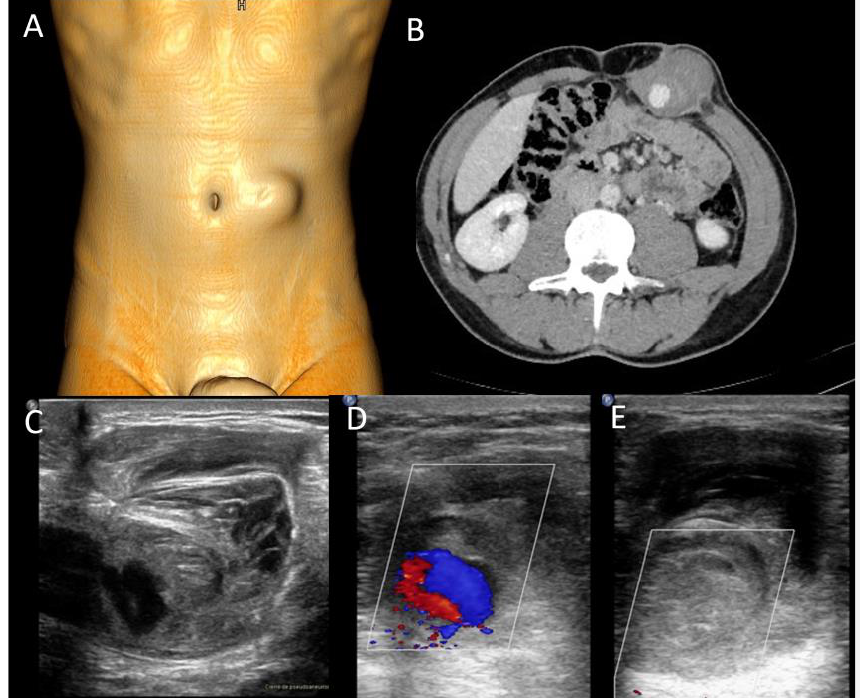
Figure 9. A 37-year-old man presenting with a pulsatile mass with trauma history. Volume render- ing cutaneous reconstruction ( A ) and axial, contrast-enhanced portal-phase CT ( B ) showed the pres- ence of a large post-traumatic pseudoaneurysm of the inferior right epigastric artery, with throm- botic apposition. B-mode US and CDUS ( C-E ) demonstrate the presence of an anechoic part, corre- sponding to the contrast-enhanced part on CT, and the heterogeneity of the thrombus. CDUS ( D – E ) shows the “ yin –yang sign”. The pseudoaneurysm was promptly treated with thrombin injection.